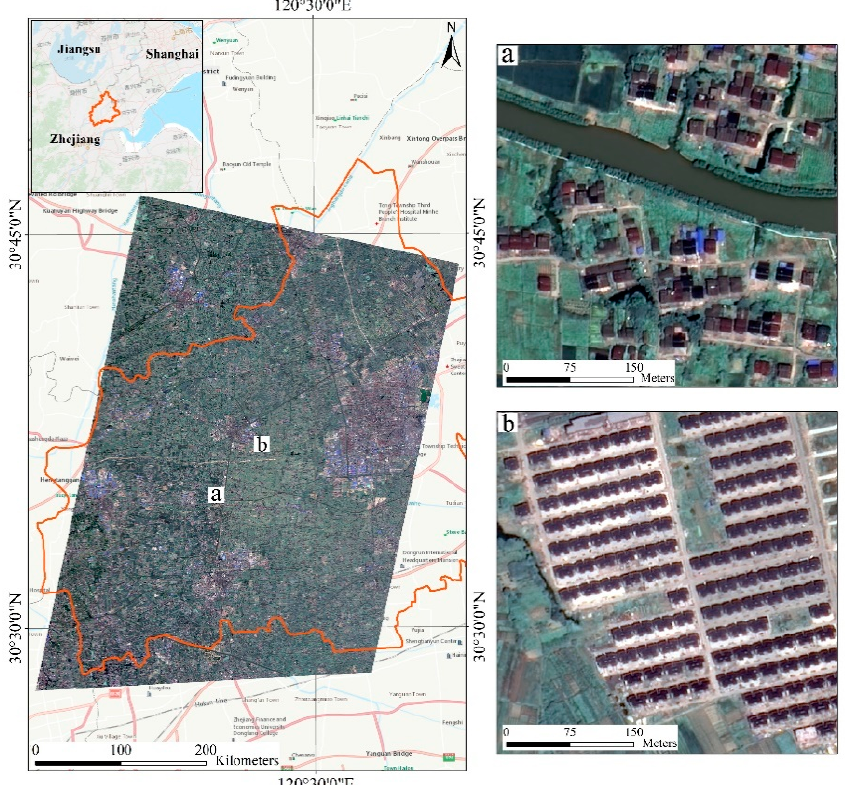
Figure 1. GaoFen-2 image of Tongxiang study area on July 2016. Example of ( a ) low-density rural settlement and ( b ) high-density rural settlement.